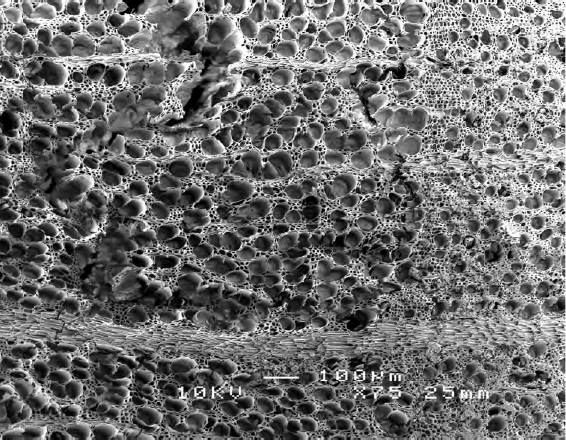
Figure 7: Beech ( Fagus sylvatica ), grave 565, cross-section (SEM micrograph: Otto Cichocki)